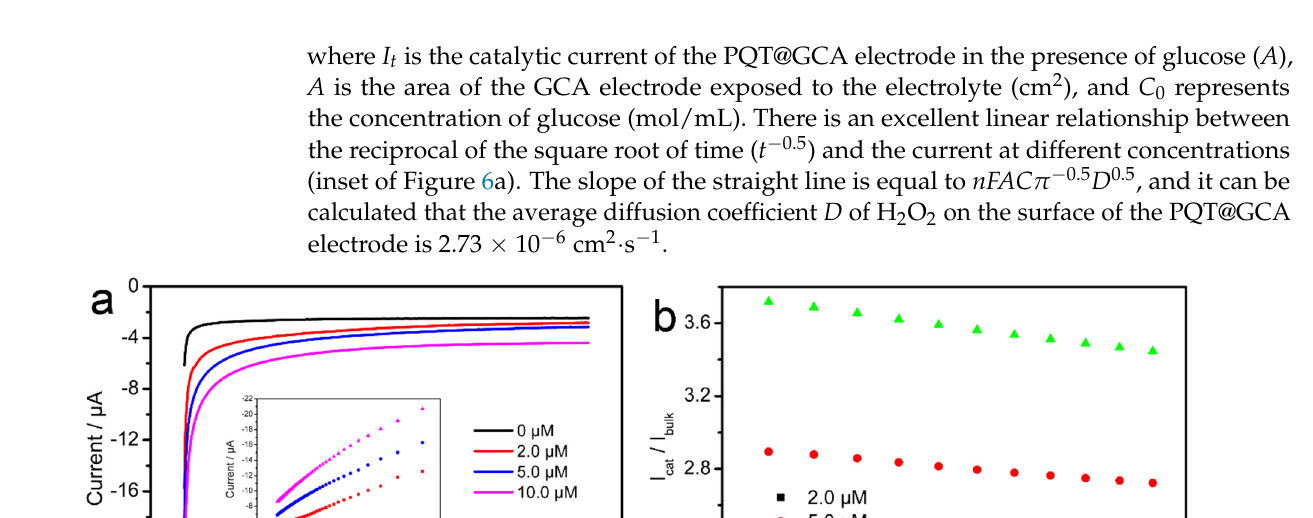
Figure 7. ( a ) SWVs of PQT@GCCA electrode in 0.2 mol/L NaClO 4 at different glucose concentration (0.05 μ mol/L–2.5 mmol/L). ( b ) The relationship between glucose concentration and reduction cur ‐ rent; inset shows the linear relationship between glucose concentration and reduction current be ‐ tween 0.05 μ mol/L–1.0 mmol/L.